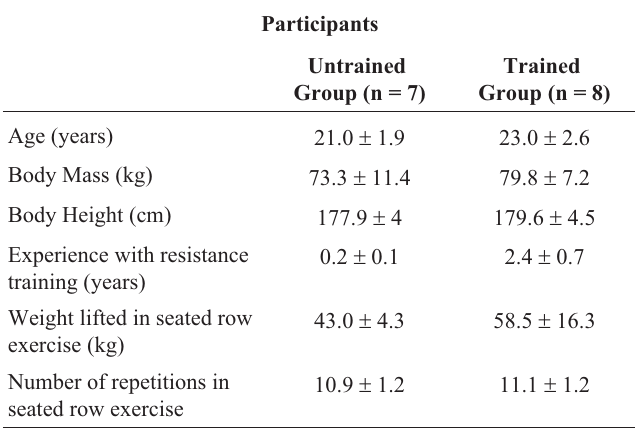
Table 1 - Mean (cid:2) standard deviation of age, body mass, body height, and experience with the resistance training of the